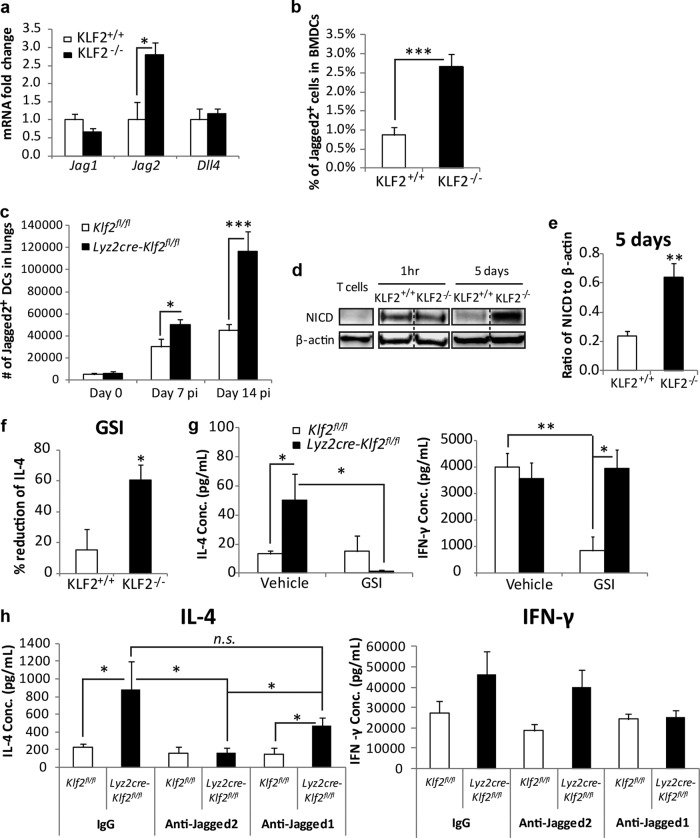
KLF2 deficiency enhances Th2 responses via the Jagged2/Notch axis. (a) Expression of Notch ligands in unstimulated BMDCs (n = 4 or 5). (b) Jagged2+ cell percentages in resting BMDCs (4 to 6 experiments). (c) Numbers of Jagged2+ DCs in the lungs of uninfected and H. capsulatum-infected mice (n = 5 to 9). (d and e) Western blot results (d) and densitometry analysis (e) of NICD in T cells after 1 h or 5 days of coculture with HK-H. capsulatum-loaded DCs (2 experiments). The dashed lines indicate that the two representative lanes were spliced together, although they were run on the same blot. (f) Percent changes in IL-4 levels with 50 µM GSI (DAPT) treatment during DC and T cell coculture (3 to 6 experiments). (g) IL-4 and IFN-γ in lung homogenates harvested at day 14 p.i. from H. capsulatum-infected mice treated with GSI (LY411,575) (n = 4 to 6). (h) Production of IL-4 and IFN-γ by activated lung CD4+ cells (CD3+ CD4+ CD69+) harvested at day 14 p.i. from the lungs of infected mice treated with anti-Jagged2 or anti-Jagged1 Ab. Cells were restimulated for 24 h ex vivo (n = 4 or 5). *, P < 0.05, **, P < 0.01, and ***P < 0.001, by Student’s t test or two-way ANOVA. Data represent the mean results ± SEM.